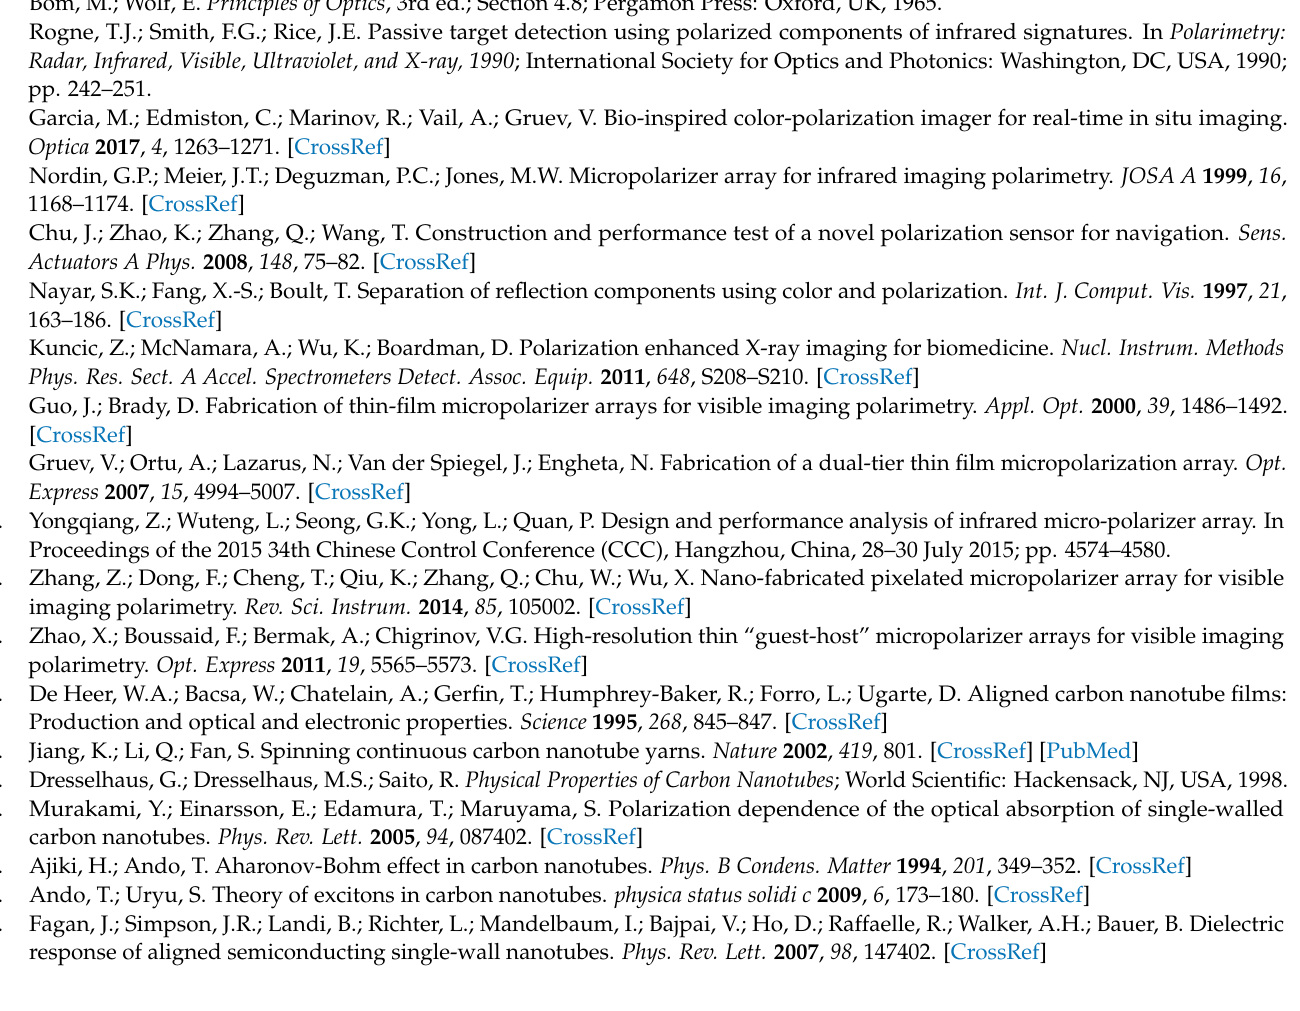
RIE. Table S2. The etching parameters of CNT film via ICP. Table S3. The deposition parameters of SiO2 via